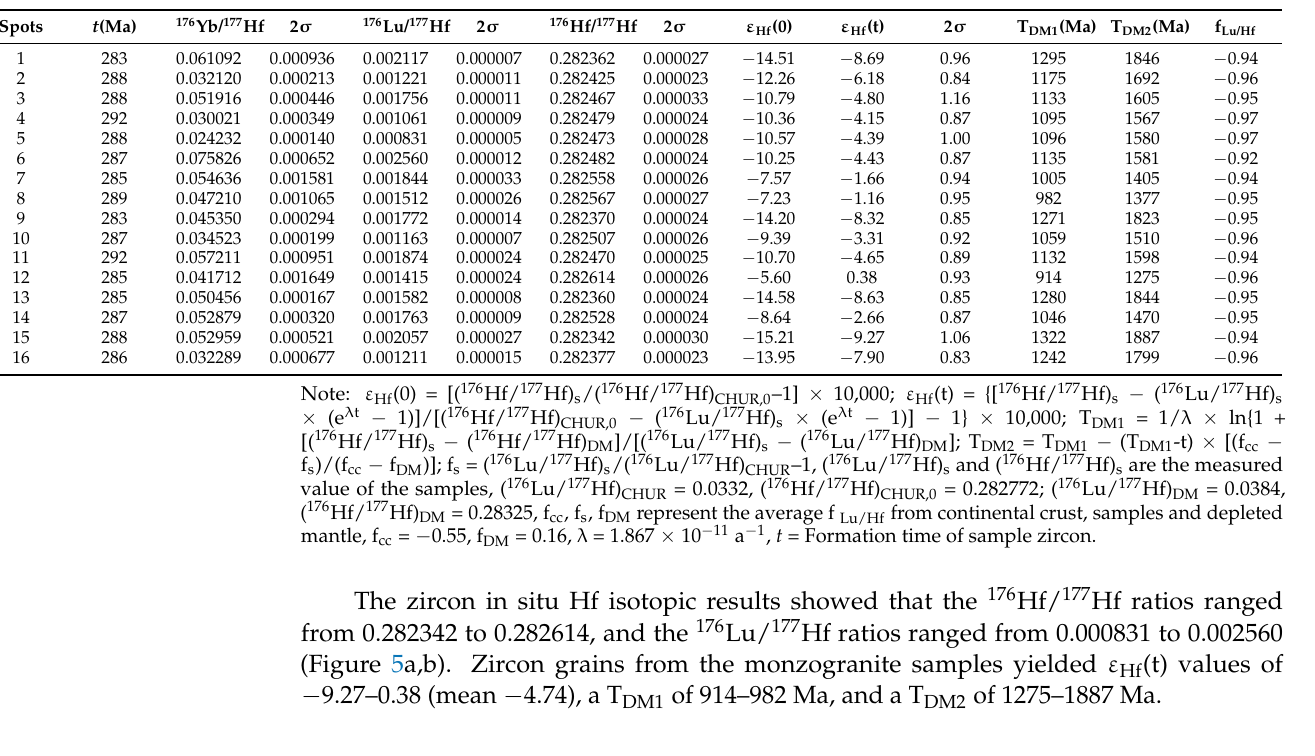
Table 4. Whole-rock Sr-Nd isotopic composition of the Zhaojinggou monzogranite, Inner Mongo- lia.